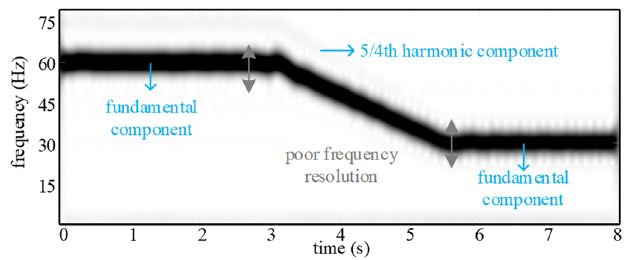
Figure 14. Experimental result using Gabor transform when σ = 50.